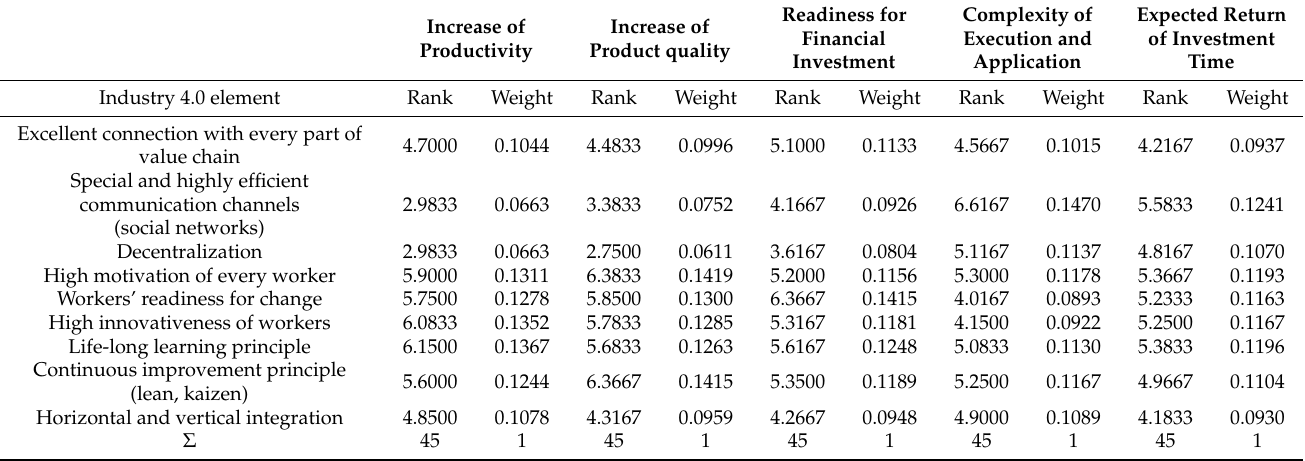
Table 6. Ranks of the elements from the “organization and human resources” group.